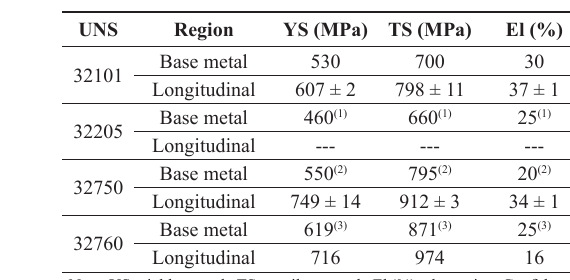
Table 7. Mechanical properties of the base metals and the welded